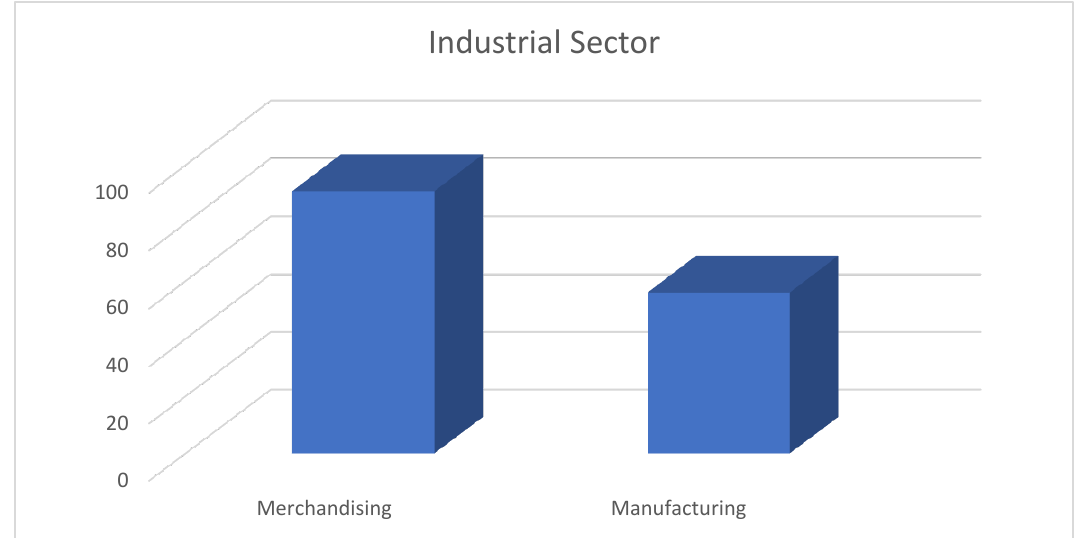
Figure 4. Distribution of Kuwaiti firms between merchandising and manufacturing.